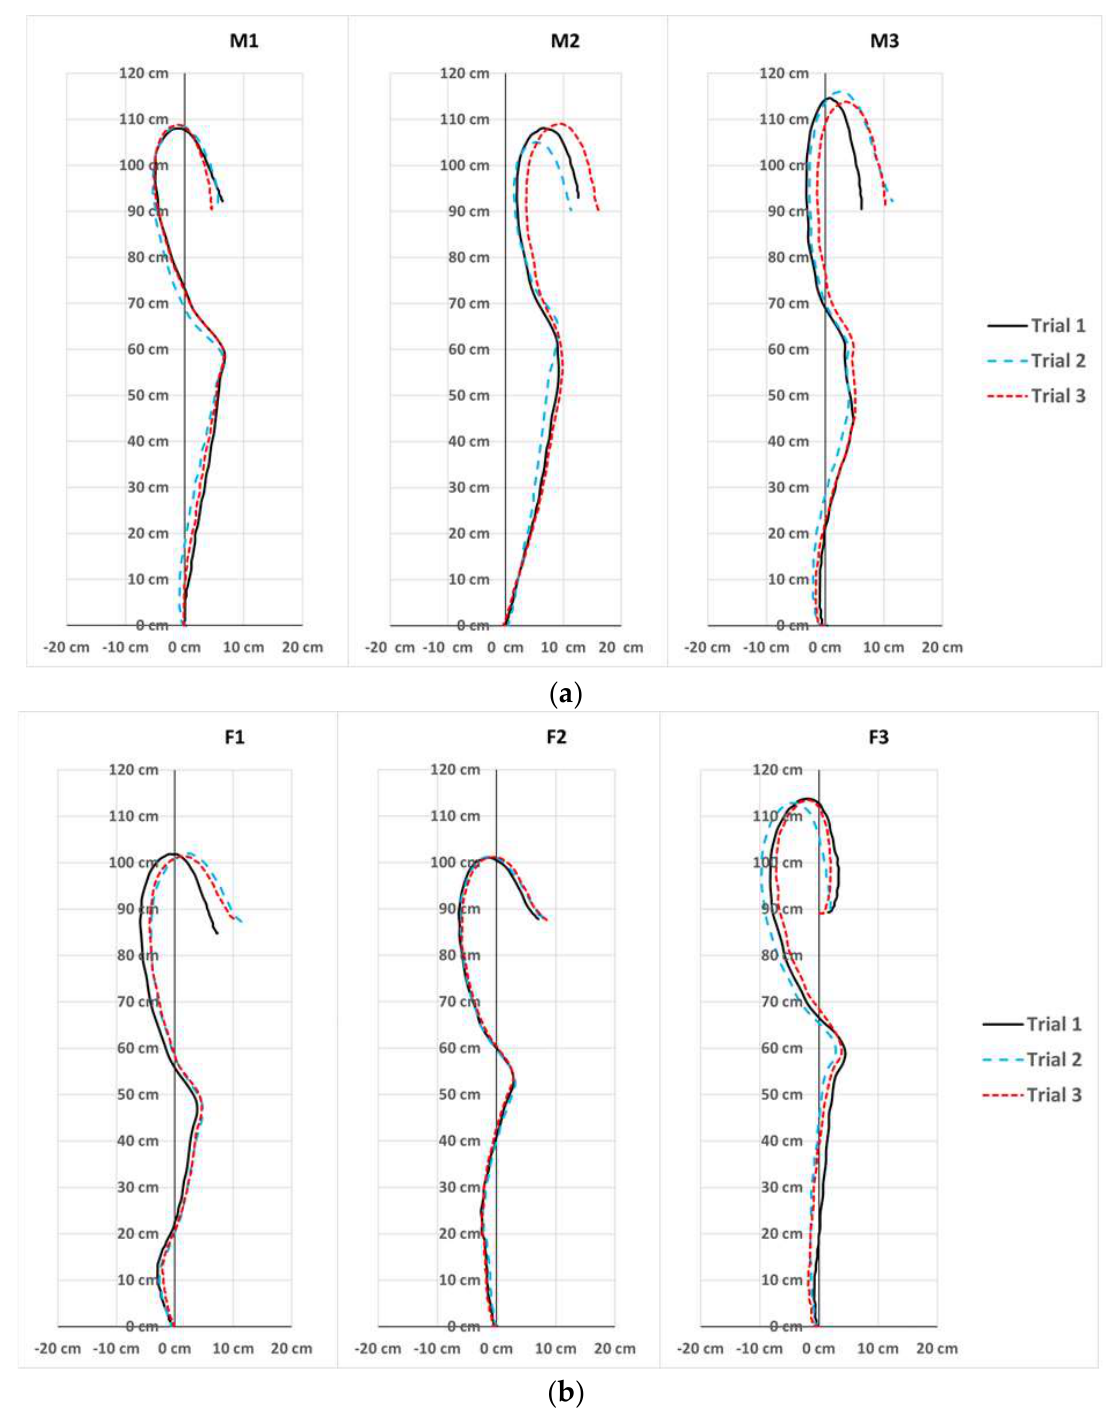
Figure 4. Barbell trajectory graphs plotted using the X and Y coordinates of the three snatch attempts performed by each of the six National Olympic Weightlifters: ( a ) male weightlifters and ( b ) female weightlifters.